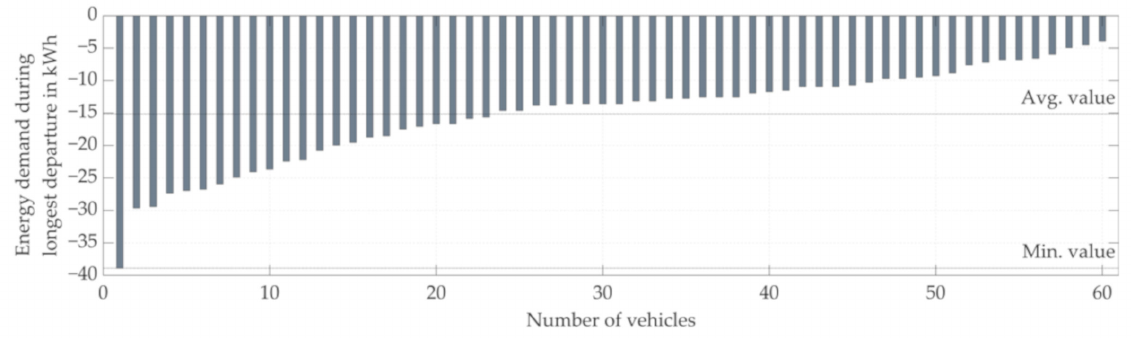
Figure 9. Diagram representing the energy demand for a single trip of each vehicle during operation for one week.